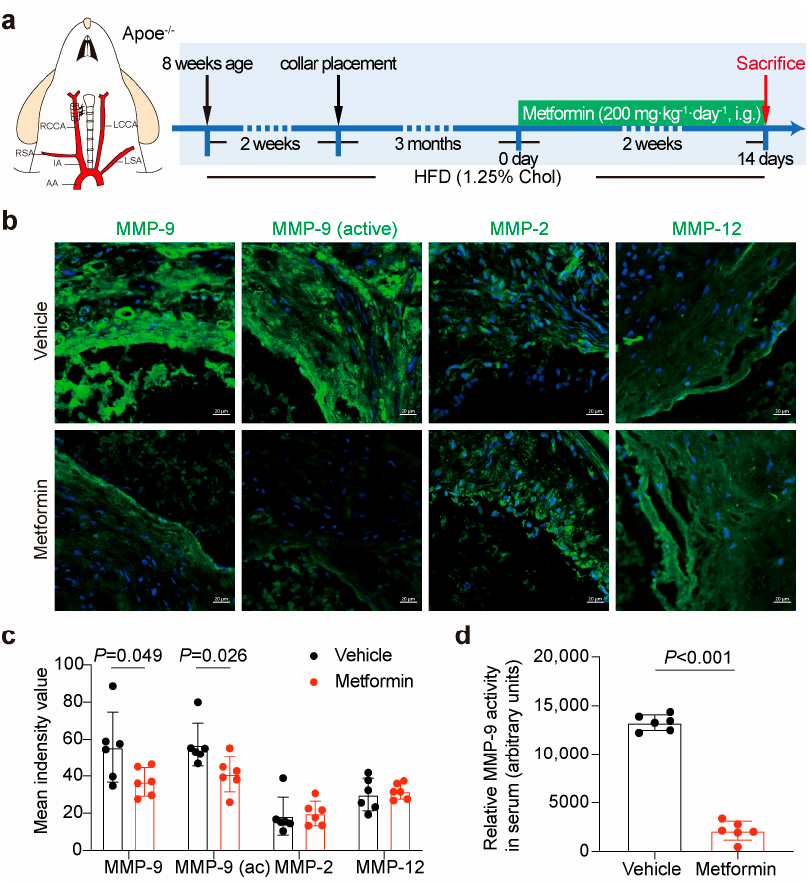
Figure 3. Metformin inhibits local plaque and circulating MMP-9 activity in ApoE-/- mice. ( a ) Flowchart illustrating the experimental procedure for actuating metformin treatment in a collar-induced carotid atherosclerotic plaque model. ( b ) Representative images of immunofluorescence staining for active-matrix metalloproteinase (MMP)-9, MMP-2, and MMP-12 in plaque after met- formin treatment. Scale bars represent 20 μ m. ( c ) Quantification of immunofluorescence staining for MMP family in plaque after metformin treatment. Unpaired Student’s t -test, n = 6 per group.